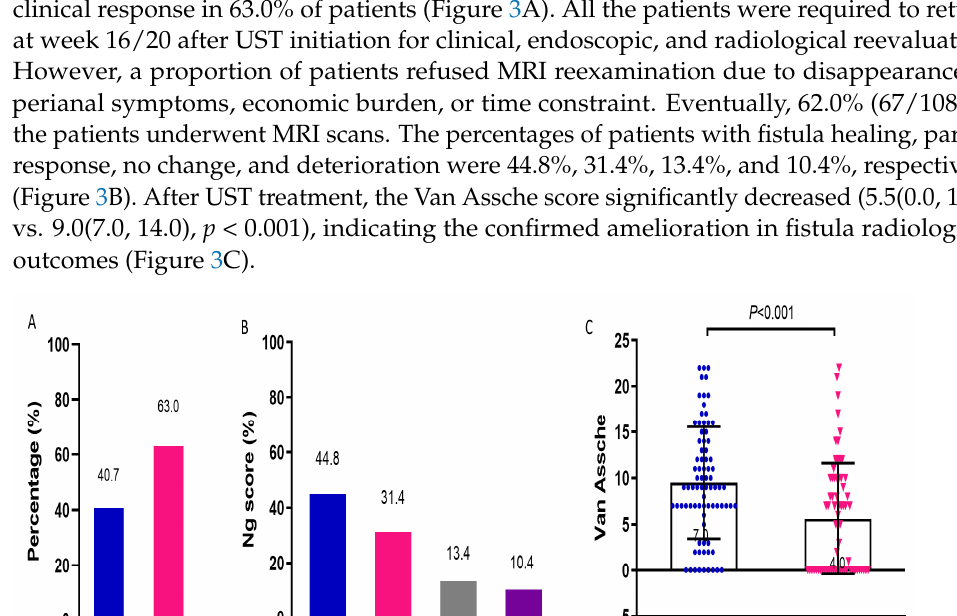
Figure 2. Efficacy of UST on CD. ( A ) Intestinal clinical evaluation using CDAI at week 16/20, n = 108. ( B ) Serological evaluation determined by CRP levels, n = 108. ( C ) Endoscopic evaluation using Rutgeerts score or SES ‐ CD, n = 99. UST: ustekinumab; CDAI: Crohn’s disease activity index; CRP: C ‐ reactive protein; SES ‐ CD: simple endoscopic score for Crohn’s disease.